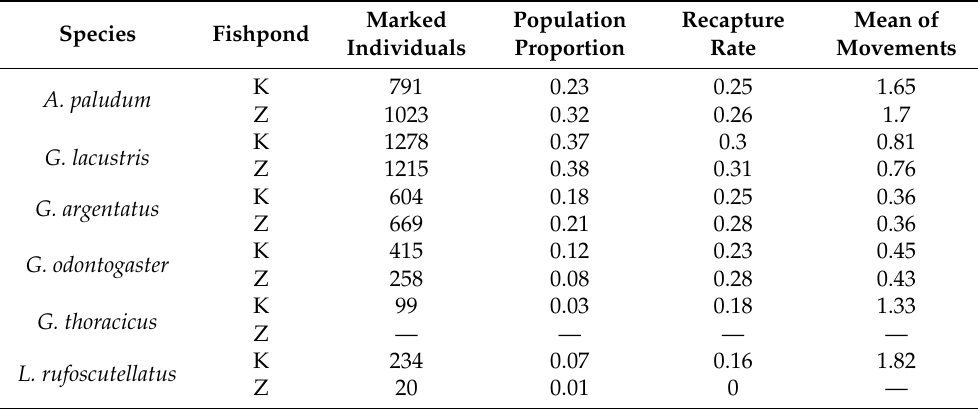
Table 1. Summary of marked individuals and catches at Kamenny fishpond (K) and Zavratsky fishpond (Z). Data pooled from all seasons. Species Fishpond